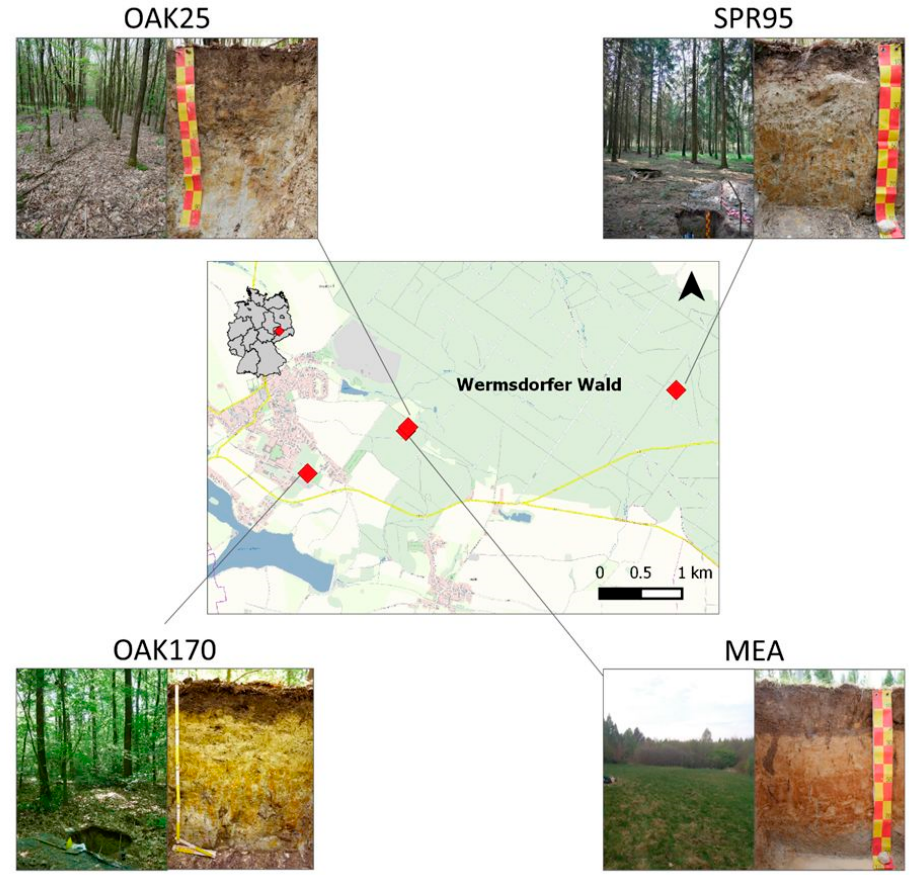
Figure 1. Overview over the site locations in the Wermsdorf Forest with photos of the surroundings and the respective soil profile. SPR95 = 95-year-old spruce stand in second generation; OAK25 = 25-year-old oak afforestation; OAK170 = old mixed deciduous stand with oaks up to 170 years old; MEA = meadow used as reference. Table 1. Basic soil properties of the four sites. Analysis for texture and C and N were performed using bulk samples per horizon. Bulk density was determined by 100 cm³ rings in 5 repetitions. Here, arithmetic mean and standard deviation (in brackets) are presented. Stone content was negligible in all analyzed horizons. Description of the horizons are according to WRB. n.d., not determined.